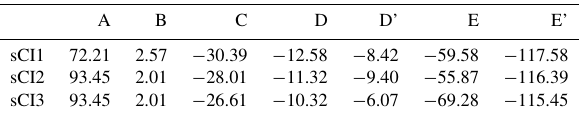
Table 2. Relative energies to reactants sCI and SO 2 ( (cid:49) E + ZPE) in kcalmol − 1 for stationary points of the all reaction. Energies were obtained at CCSD(T)/6-311G(d,p) level of theory and zero point energies were obtained at the BMK/6-311 ++ G(3df,3pd) level of